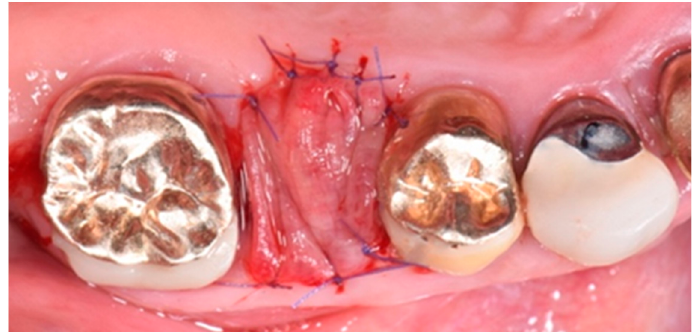
Figure 6. Placement of the second layer of PRF membrane over the first layer, in order to cover the post-extraction alveolar socket. The edges of the membrane were placed under the mucosal flaps and sutured to the surrounding gingiva.